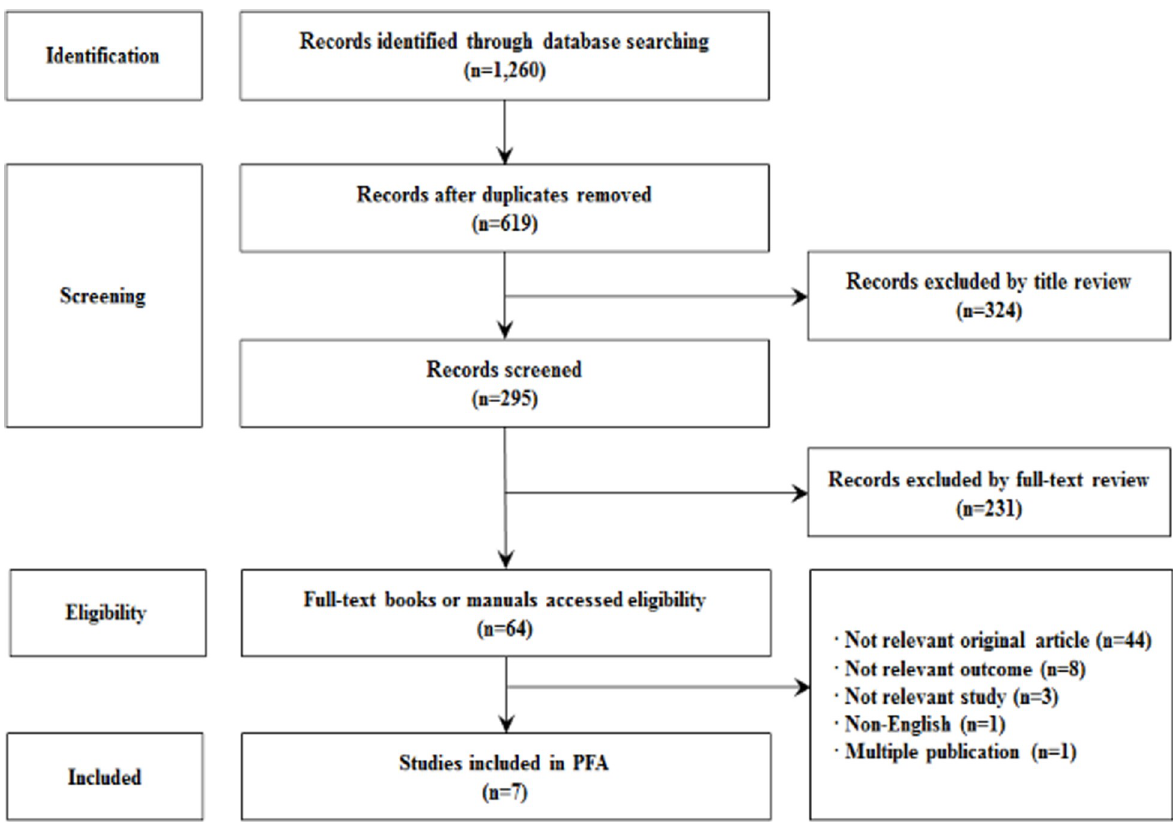
Fig 1. Flow chart of the sample selection